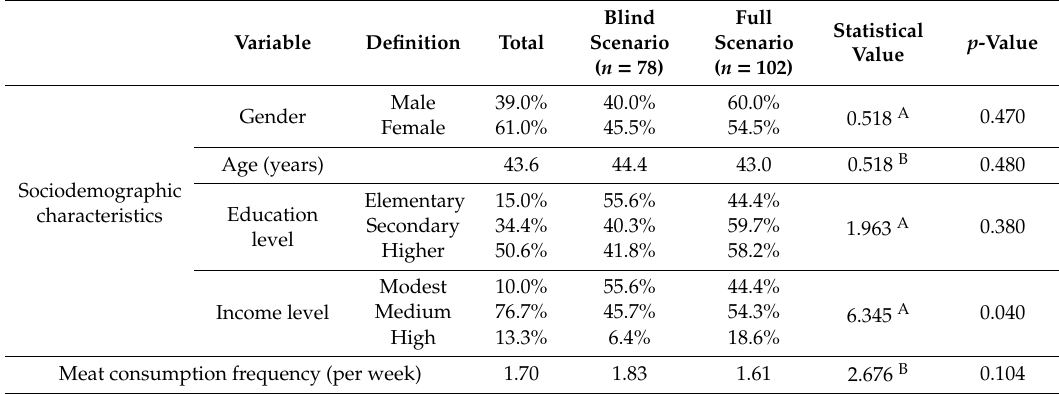
Table 1. General description of the consumer sample by information